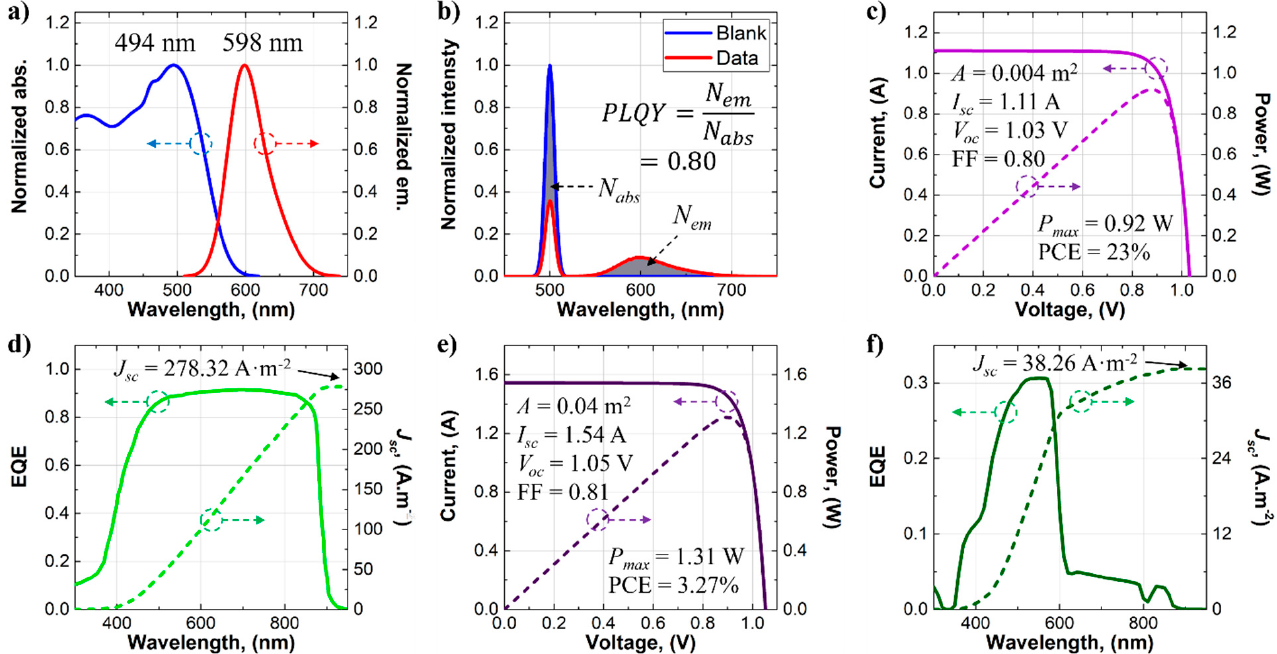
Figure 2. ( a ) Normalized absorption and emission spectra and ( b ) results for the PLQY of DCJTB in the LSC. Results for the ( c ) I–V and ( d ) EQE measurements of the GaAs solar cells. Results for ( e ) the I–V and ( f ) the EQE measurements of the LSC.